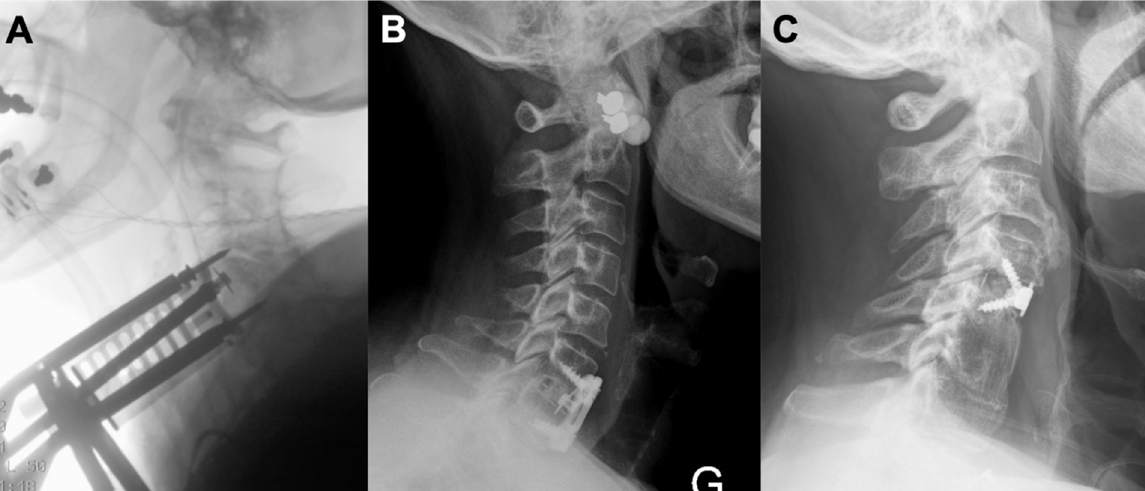
Figure 1. Anterior cervical cage placement and fixation. ( A ) Intraoperative lateral X-ray to assess ACDF cage placement. Casper pins can be seen in the vertebral bodies above and below. ( B ) Post-operative lateral X-ray showing a single level ACDF (HRCC, Eurospine) at C6-C7 secured by a plate (Venture, Medtronic). ( C ) Post-operative lateral X-ray showing a single level ACDF at C4-5 (Zero-P cage, DePuy Synthes) for the treatment of myelopathy due to adjacent segment disease after a fusion with autologous iliac crest bone at C5-6. ACDF = Anterior Cervical Discectomy and Fusion